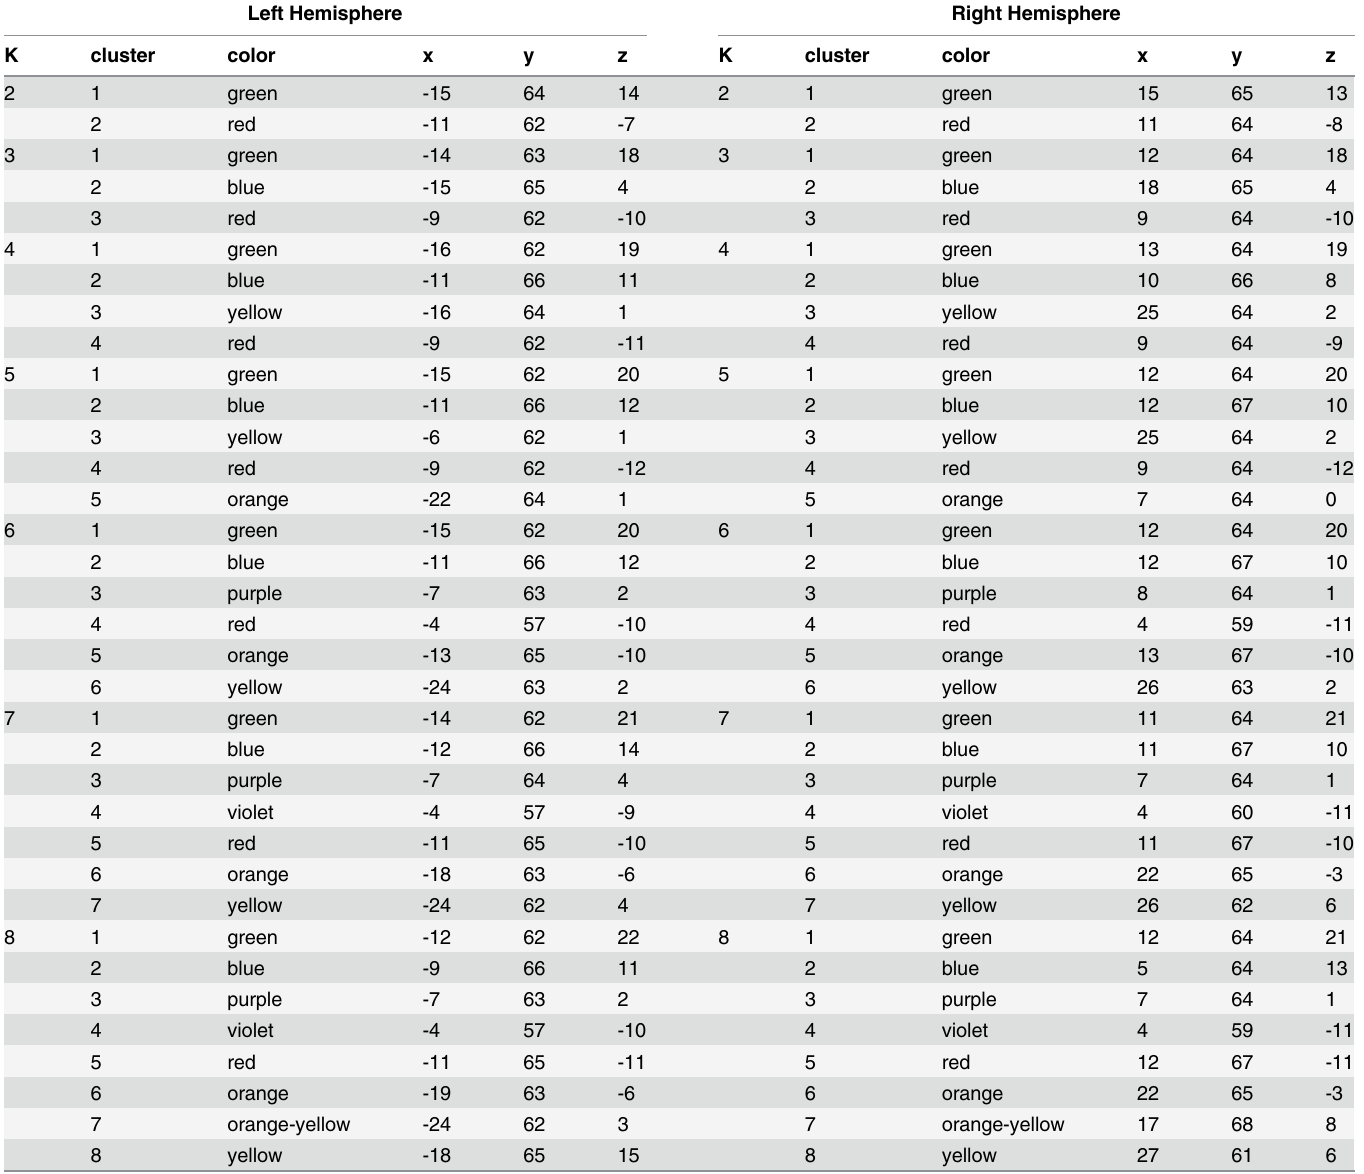
Table 1. Coordinates for center-of-mass of clusters from each of the k-means parcellations. Left